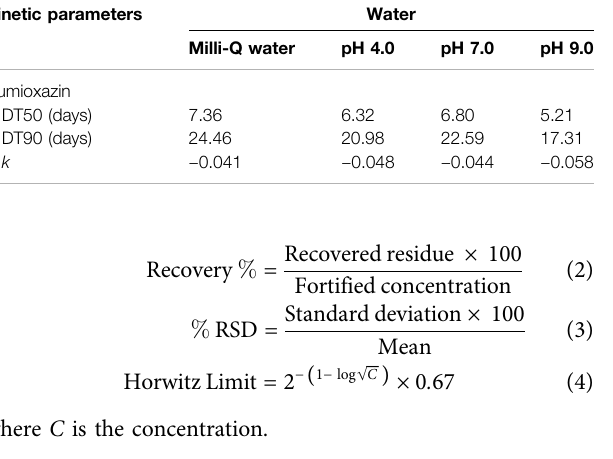
TABLE 5 | Kinetic parameters for photolytic decontamination of fl umioxazin in water under direct sunlight. Kinetic parameters